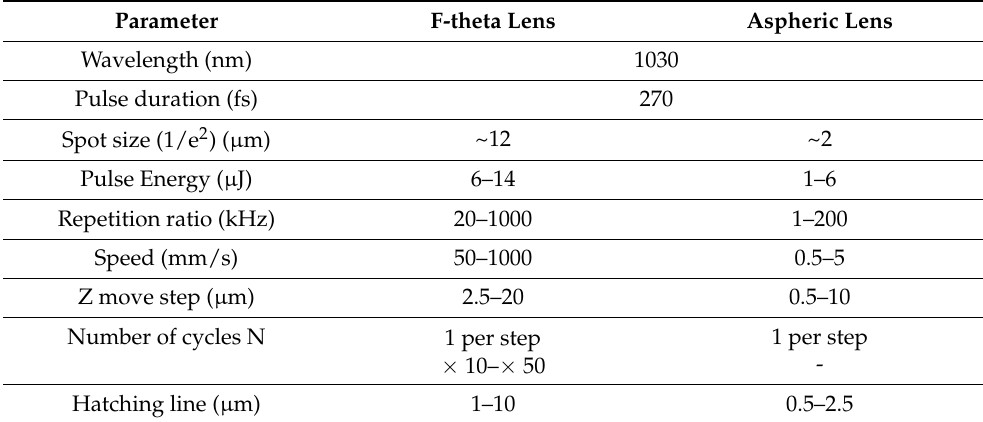
Table 1. Laser and process parameters used for optimization of laser cutting of the microchannel. F-theta